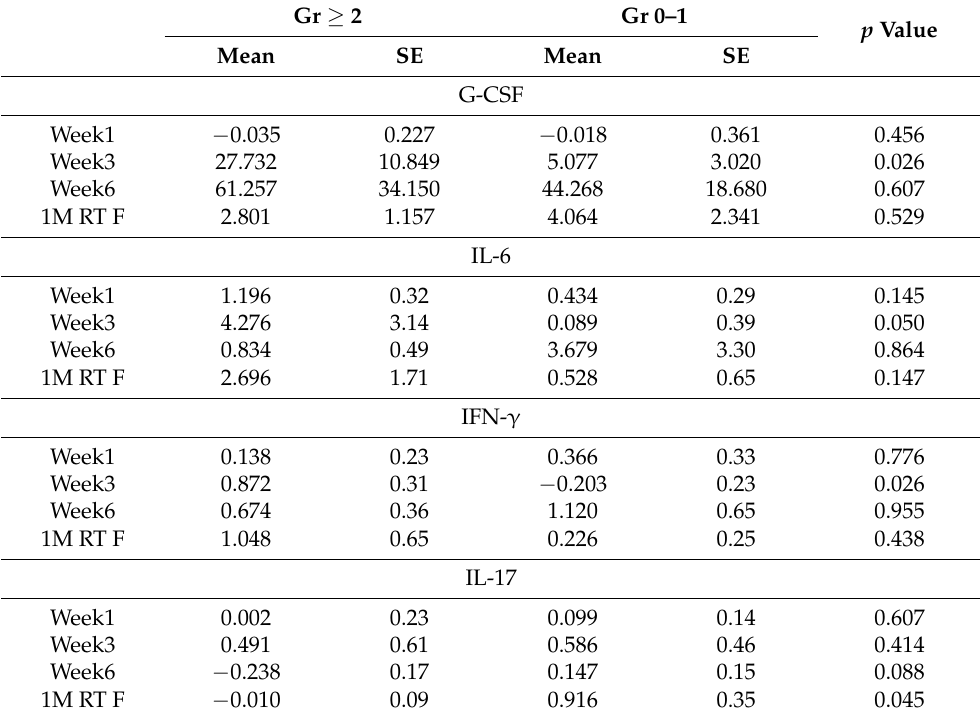
Table 2. Relative changes in cytokine levels compared to pre-RT